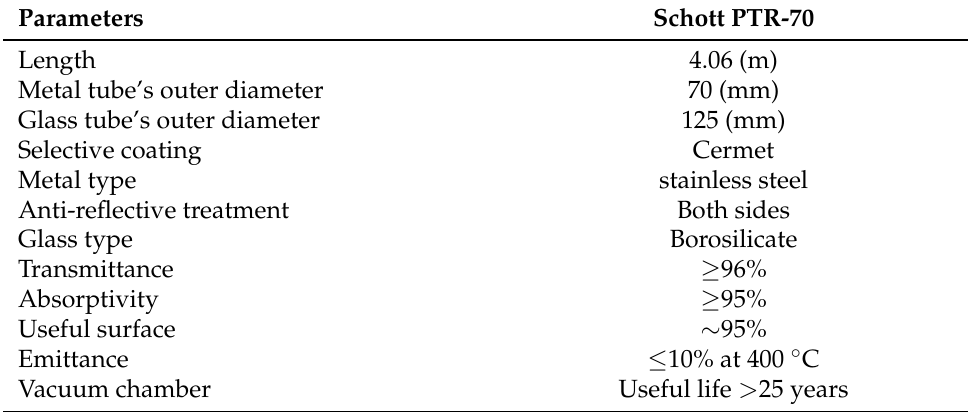
Table 2. Schott PTR-70 characteristics